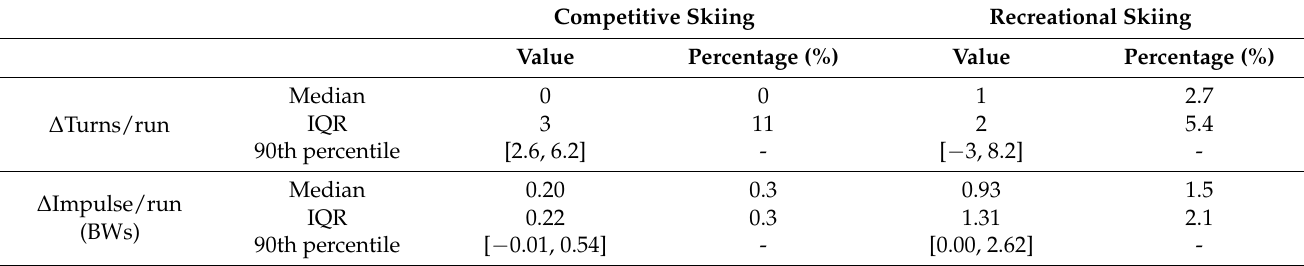
Table 6. Error for number of turns per run and impulse per run. Number of runs: competitive skiing: 27, recreational skiing: 63. Nomenclature: bodyweight seconds (BWs), interquartile range (IQR), error ( ∆